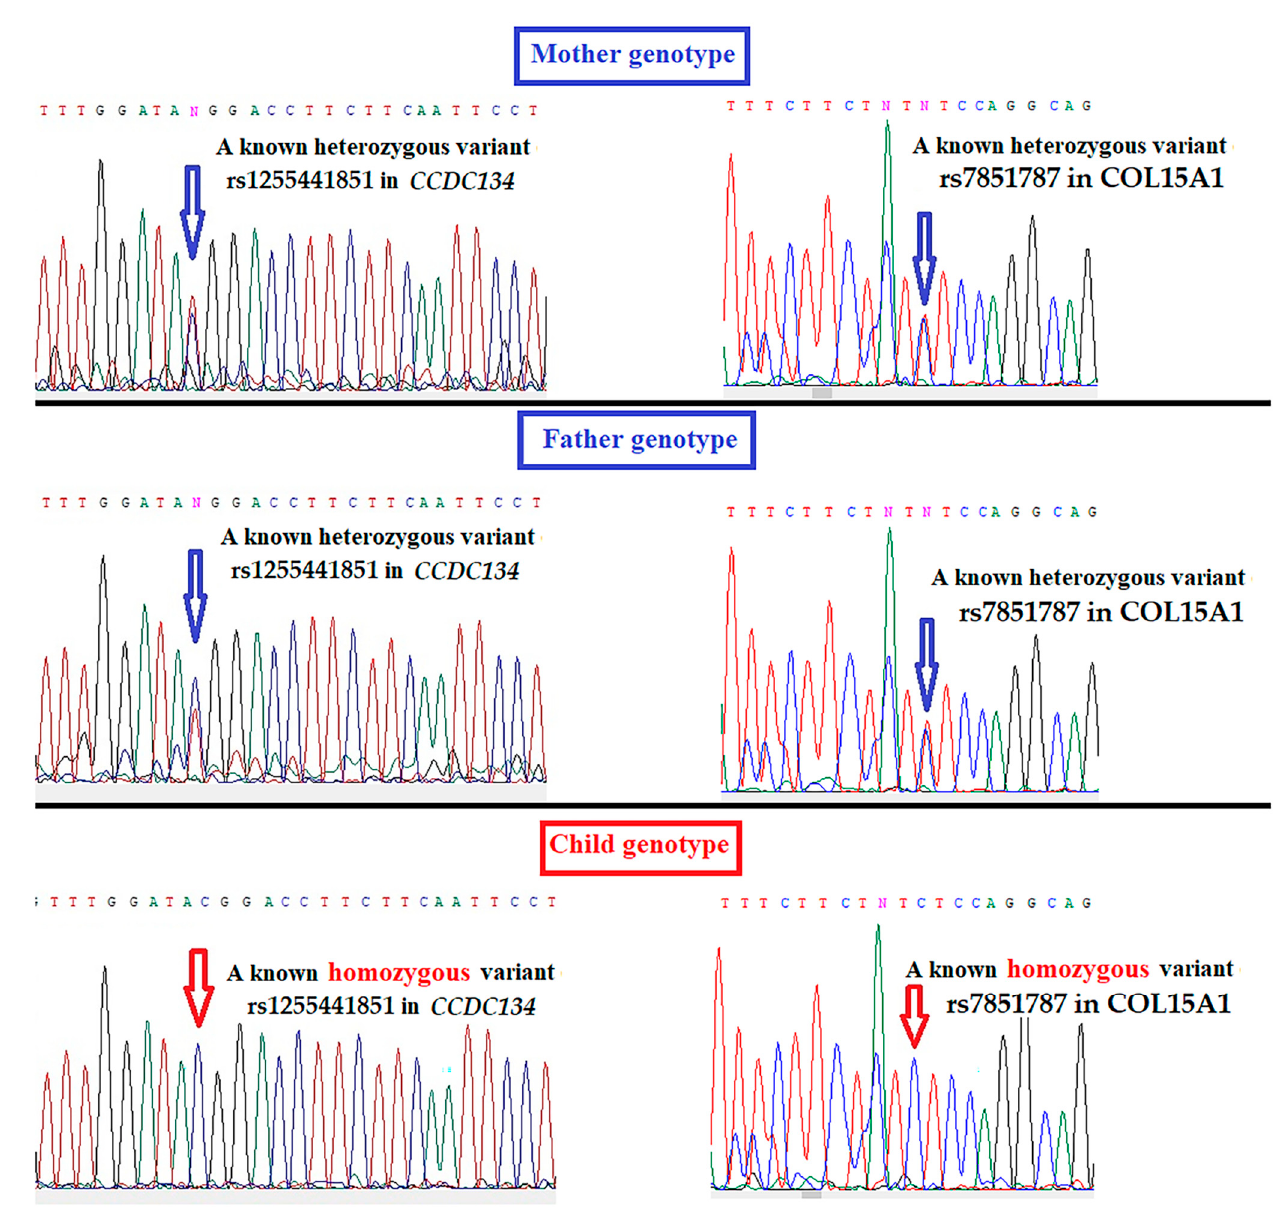
Figure 7. Sequencing chromatograms demonstrating the genetic variants of the CCDC134 and COL15A1 genes found in the family.